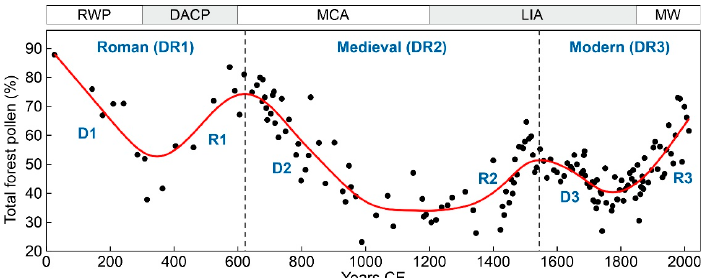
Figure 4. Historical deforestation–recovery (DR) cycles, as recorded with the total forest tree pollen. Black dots: raw data, red line: smoothing spline. Climatic phases (cold intervals in gray): RWP, Roman Warm Period; DACP, Dark Ages Cold Period; MCA, Medieval Climate Anomaly; LIA, Little Ice Age; MW, Modern Warming Table 1. Parameters used for comparisons among Roman (DR1), Medieval (DR2) and Modern (DR3) deforestation cycles in the Montcortès region (raw data: